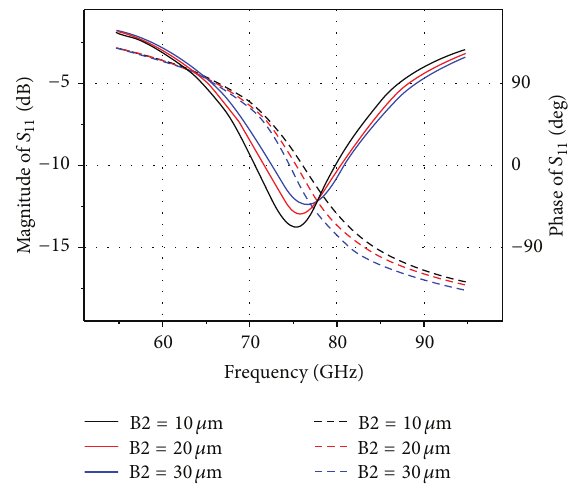
Figure 8: Magnitude and phase of reflection coefficient versus geometrical parameter B2.